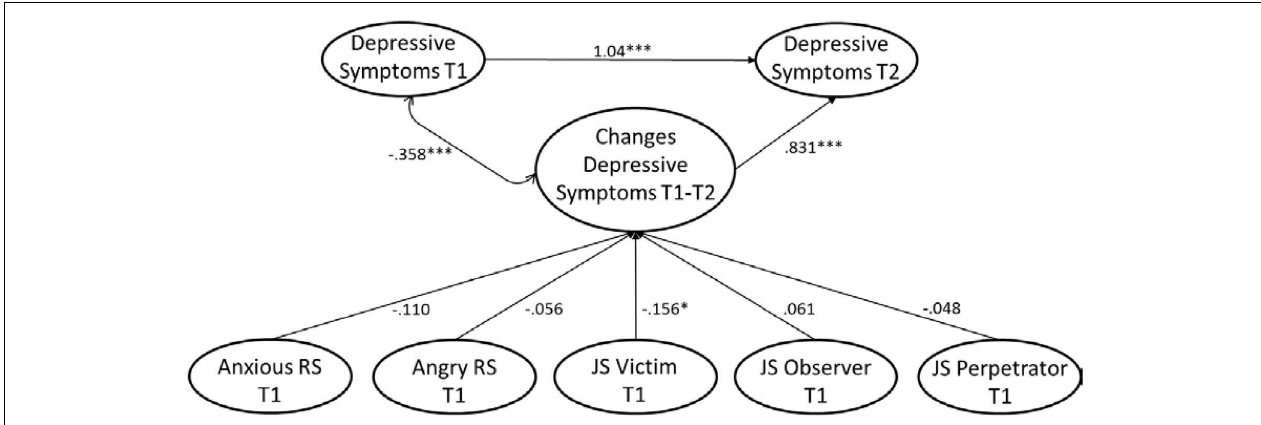
FIGURE 2 | Latent-change model with Tl sensitivity subscales predicting changes in depressive symptoms between Tl and T2 assuming strong measurement invariance in depressive symptoms and controlled for gender and age. Measurement model for sensitivity subscales as in Figure 1 . Additional indicator factor for second indicators of depressive symptoms at Tl and T2. Factor loadings on the indicator factor constrained to be equal. All predictors allowed to correlate. Standardized model results